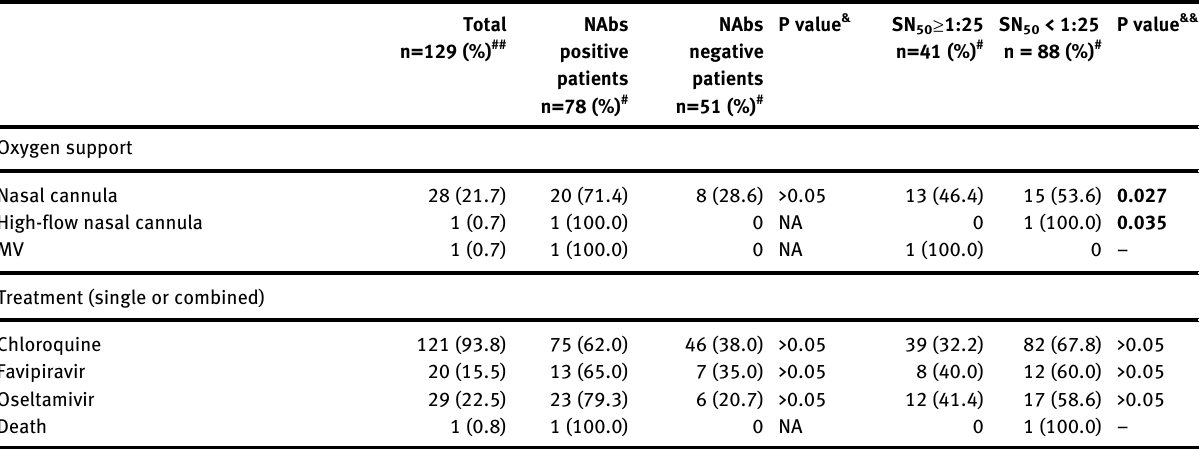
Table  : Comparison of demographic, clinical, and radiologic characteristics of the severe and non-severe patients with COVID- 